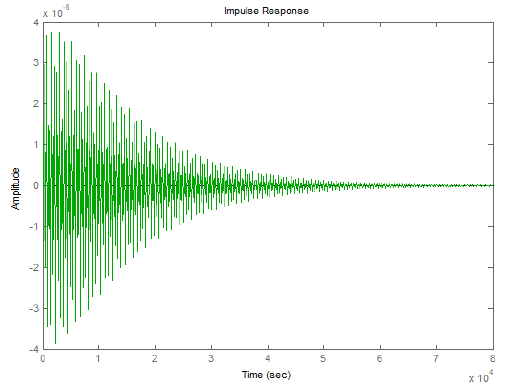
Figure 4. impulse response for the closed